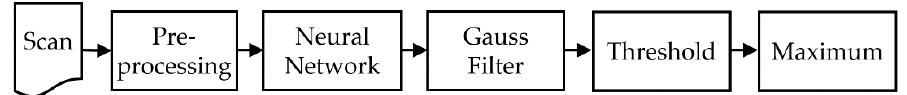
Figure 7. A flowchart of the inference procedure. A single scan at a time is preprocessed and fed through the neural network. The resulting segmentation is filtered and binarized via a threshold. The maximum in the resulting binary image, either one or zero, is the final